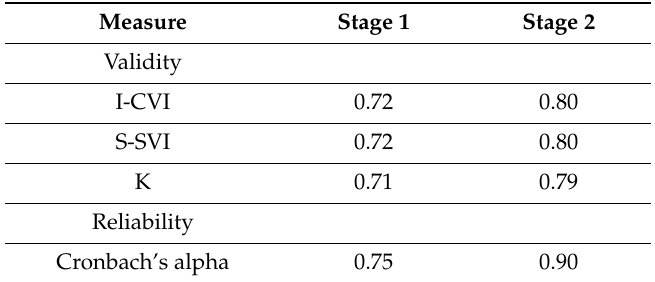
Table 2. Survey validation